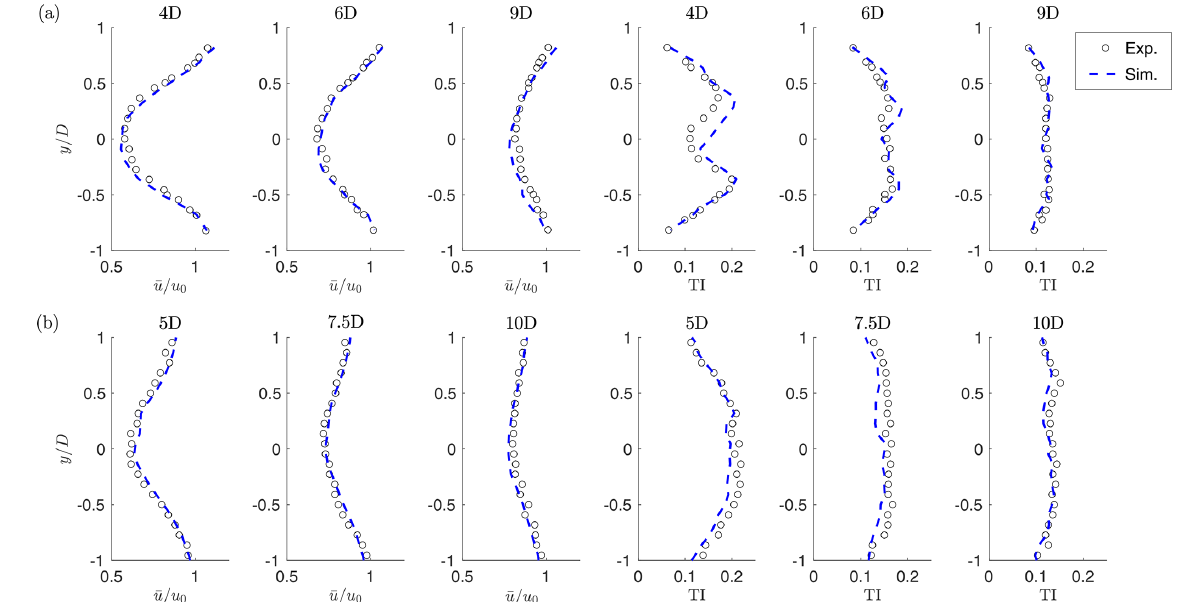
Figure 8. Horizontal hub-height profiles of normalized time-average streamwise velocity and turbulence intensity, for the medium (a) and high (b) inflow TI cases. Black o symbols: experimental results; blue dashed line: G1 simulations. Table 2. Power and thrust coefficients for the different turbine models in the two considered operating conditions. Coefficient C P C T Turbine model G1 G178 G178-nRA G178-MC G1 G178 G178-nRA G178-MC γ = 0 ◦ 0.420 0.475